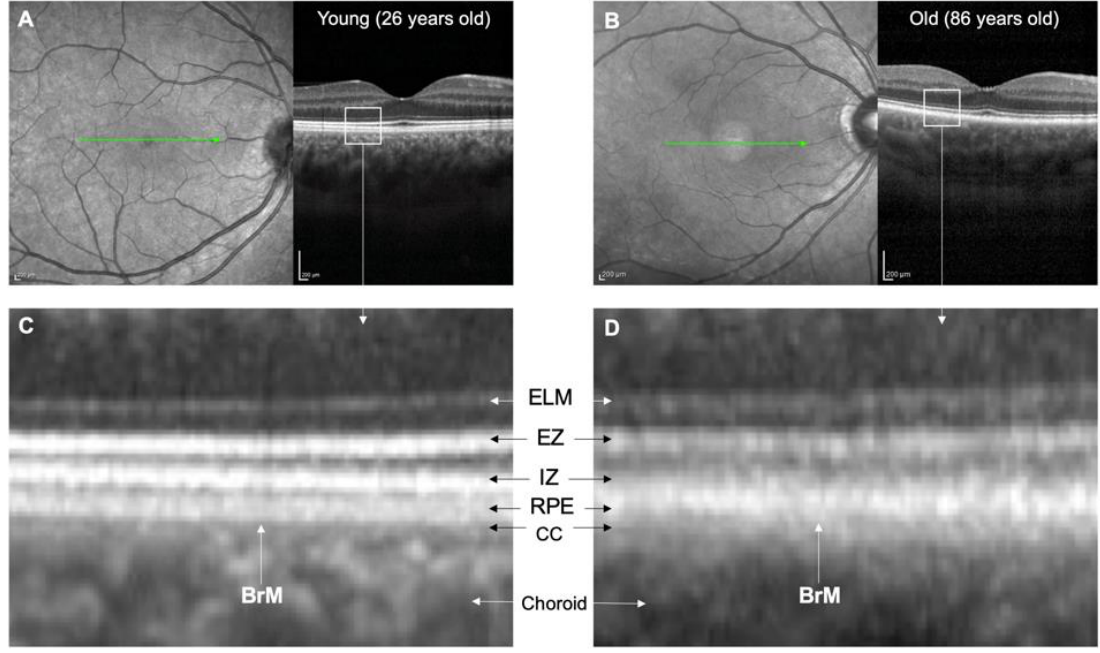
Figure 4. Comparison of OCT images of younger and older retinas. (A,B) show scanning laser ophthalmoscope fundal images and corresponding horizontal 15-degree OCT line scans of a 26-year-old female with a clear lens and an 86-year-old female who had undergone cataract surgery. The OCT images were averaged from 100 B-scans. ( C , D ) show high magnification views of the outer retina. In the 26-year-old individual, clear distinctions can be made between the IZ, RPE, BrM, and CC. However, in the 86-year-old individual, these structures are indistinct, and there is apparent thickening of BrM and thinning of the CC. Abbreviations: BrM, Bruch’s membrane; CC, choriocapillaris; ELM, external limiting membrane; EZ, ellipsoid zone; IZ, interdigitation zone; OCT, optical coherence tomography; RPE; retinal pigment epithelium.